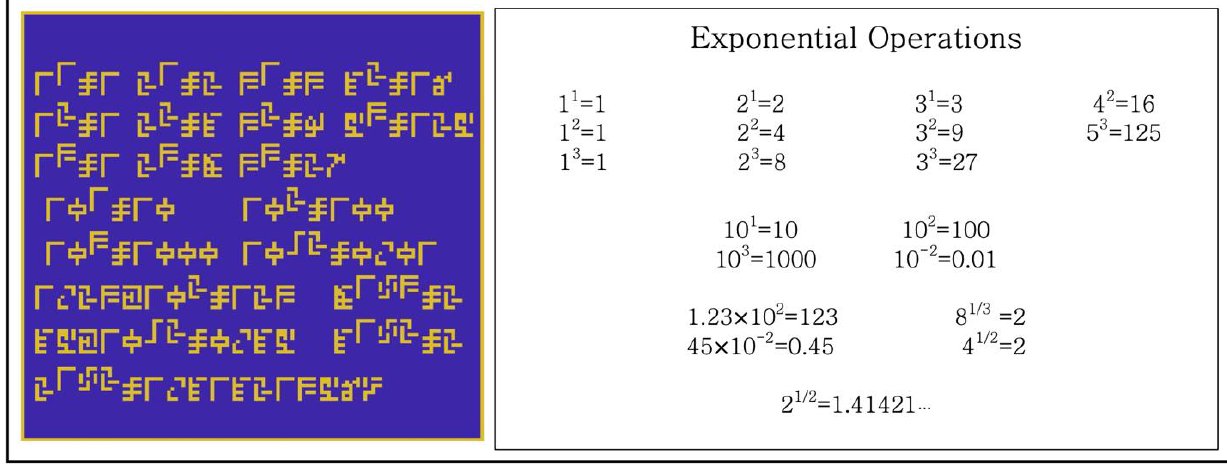
Figure 9. Pictural representation and explanation of exponents in the message, page 3.